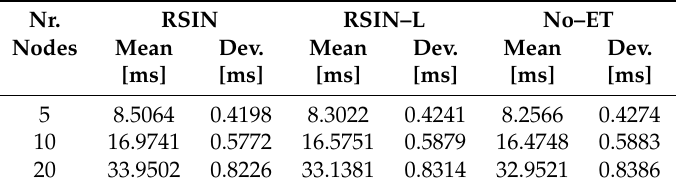
Table 6. Statistics of the MCT and Impact of the RA